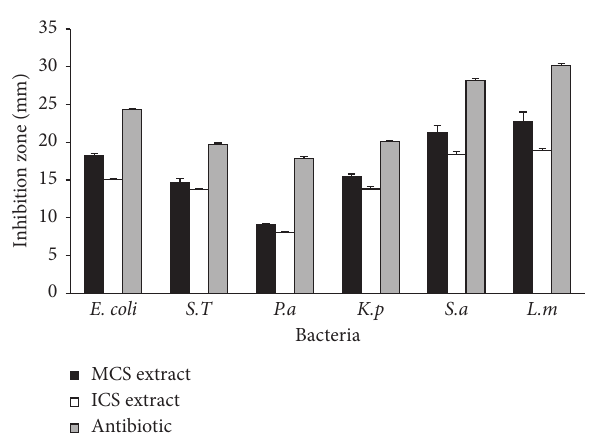
Figure 1: Inhibition zones of aqueous extracts of C. sativus against the 4 tested bacteria. MCS extract: Moroccan C. sativus extract; ICS extract: Italian C. sativus extract; E. coli : Escherichia coli ATCC 25922; S.T: Salmonella typhimurium ATCC 14028; P.a: Pseudo- monas aeruginosa ATCC 15442; K.p: Klebsiella pneumoniae ATCC 43816; S.a: Staphylococcus aureus ATCC 25923; L.m: Listeria monocytogenes ATCC 13932. Table 5: Results for MIC and MBC for aqueous extract of C. sativus . Bacteria